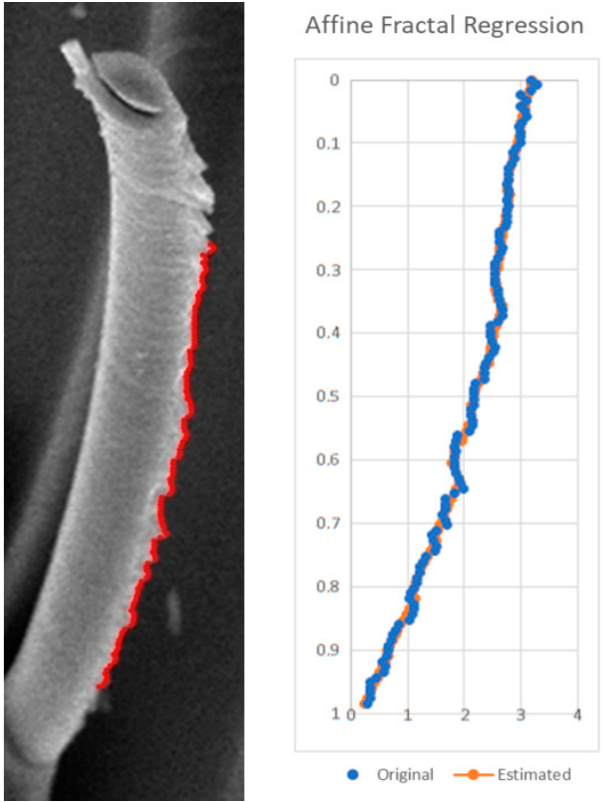
Figure 3. Enlarged glass fiber ( left ) and estimated fractal curve of a fiber ( right ).